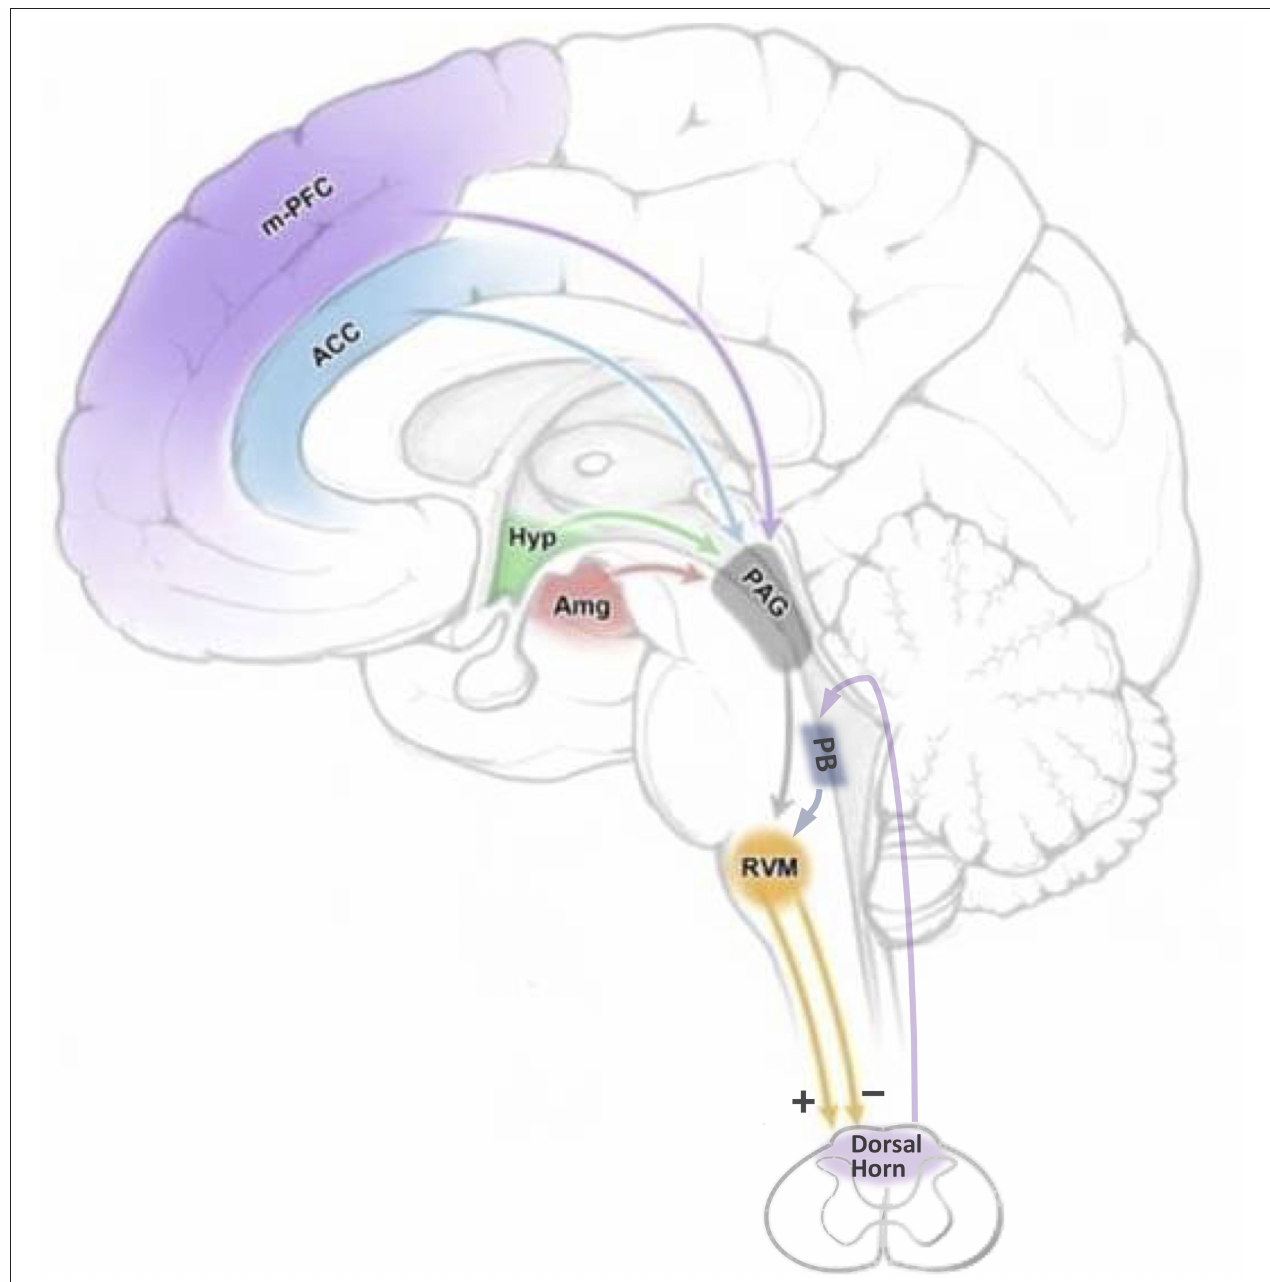
FIGURE 1 | Top-down and bottom-up inputs through which cognitive and emotional factors could influence nociceptive transmission by modulating the firing of RVM pain-modulating neurons. Cognitive and emotional processes mediated by higher structures have the potential to influence the RVM through the PAG, and in some cases, directly. Bottom-up, nociceptive, inputs are relayed from the spinal cord to the RVM via the parabrachial complex. ACC: anterior cingulate cortex; Amg: amygdala; Hyp: hypothalamus; m-PFC: medial prefrontal cortex; PAG: periaqueductal gray; PB: parabrachial complex; RVM: rostral ventromedial medulla. Adapted from Cleary, D. and Heinricher, M.M. Neuroanatomy and neurophysiology of pain. In Winn, H.R. (Ed)., Youmans and Winn Neurological Surgery, 8th Ed ., Elsevier Saunders, Philadelphia,